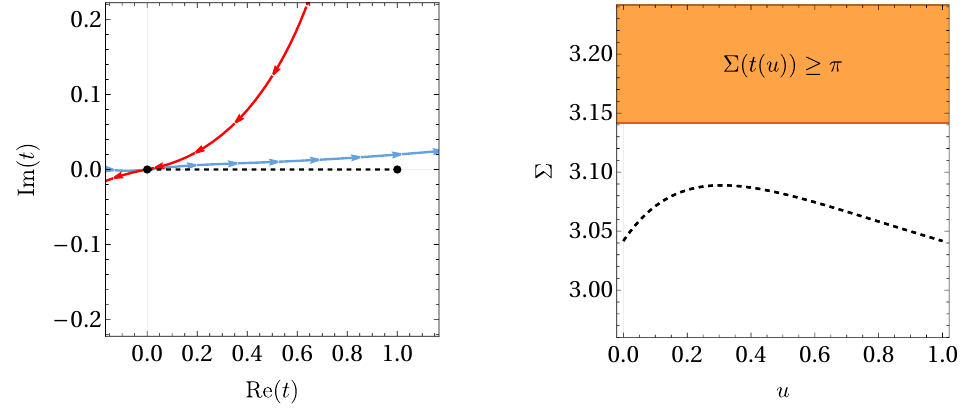
Figure 6 . Left : complexified time plane for a solution with classical boundary conditions just off-shell of the expanding saddle point. Here q 0 = 2 , q 1 = 10 , and Λ = 3 , and the perturbation about the expanding saddle is taken to be N = 2 − i/ 10 . Black dots reside at t = 0 and t = 1 , indicating the end points of the time path specifying the metric. The blue directed line is the line of maximal angle, and the red directed line is that of minimal angle, so an allowable path must reside in between under forward time evolution — recall we want Re( t ) to grow monotonically from 0 to 1 . How those minimal and maximal angle directed lines are found is explained in section 2.3.3. We can see that the point t = 1 is reachable while staying below the blue line, for example using the black dashed path, which is simply on the real- t axis here. Right : we explicitly verify that the dashed path is indeed allowable, by plotting the full Σ along it. It everywhere stays below the limiting value π , indicated by the orange